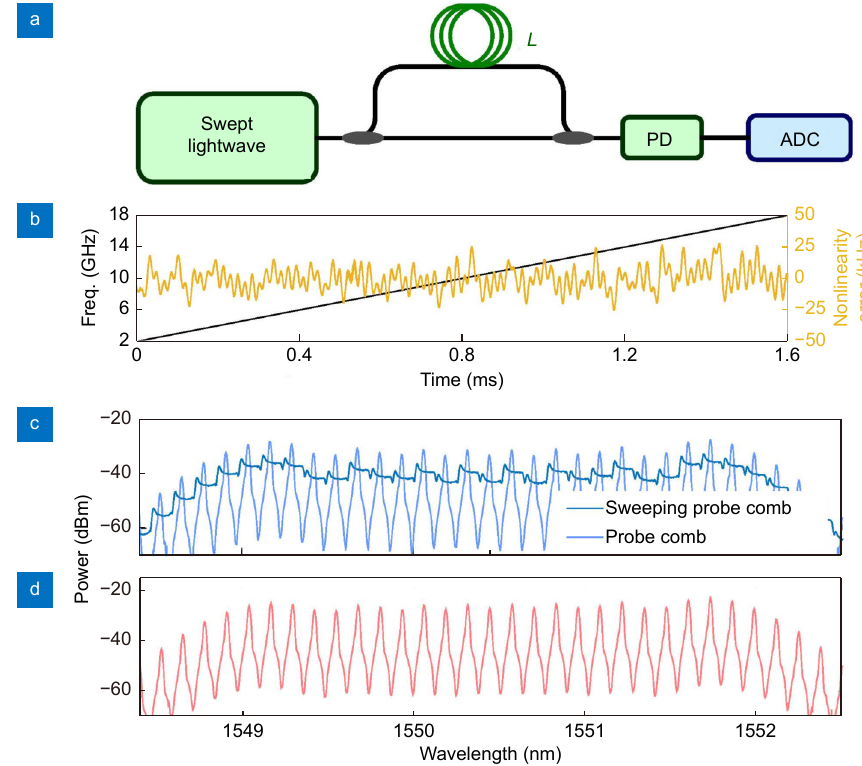
Fig. 3 | ( a ) Experiment setup of swept lightwave characterization. ( b ) Sweep range and nonlinear error of the ultra-linearly swept optical source measured by using an unbalanced Mach-Zehnder interferometer. ( c ) Optical spectrum of the probe comb with a stabilized optical source and a linearly-swept optical source. ( d ) Optical spectrum of the local comb with a stabilized optical